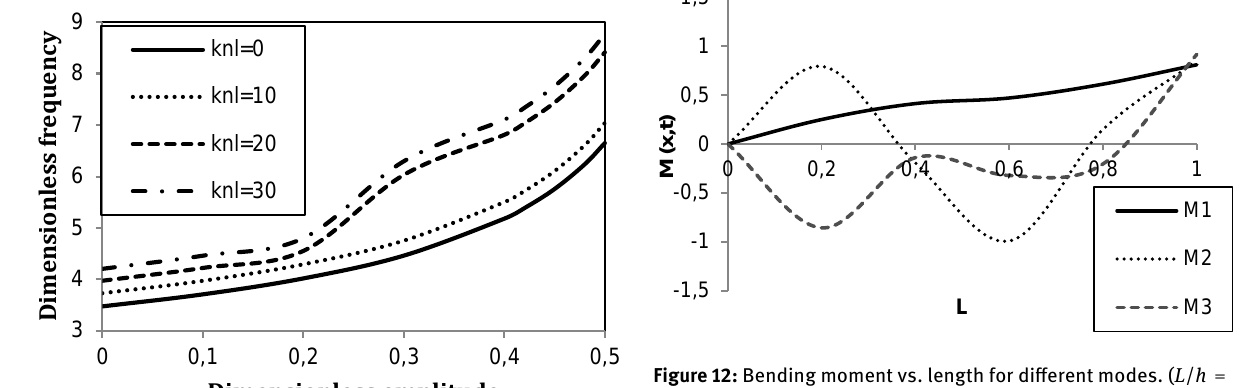
Figure 12: Bending moment vs. length for different modes. ( L / h = 10 , V = 0 , K w = K p = 20 , ∆T = 20 ∘ , ∆H = 10 , α = 0.5 )